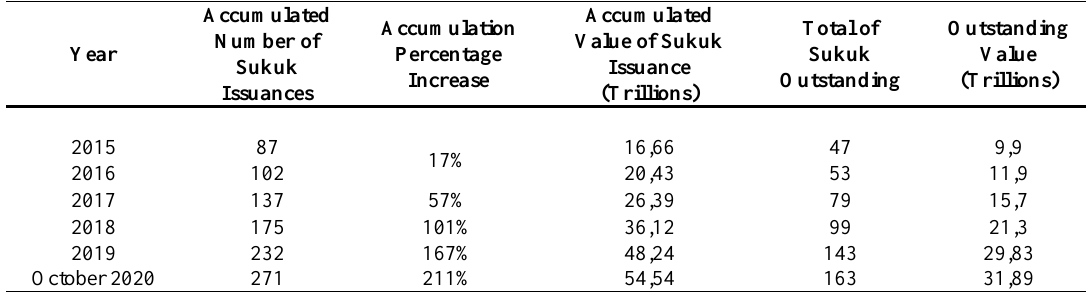
Table 1. Corporate Sukuk Development Data in